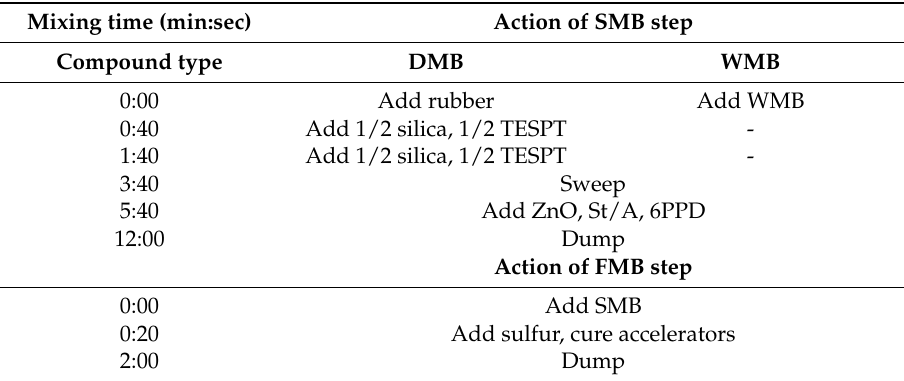
Table 3. Mixing procedures for the DMB compound and WMB